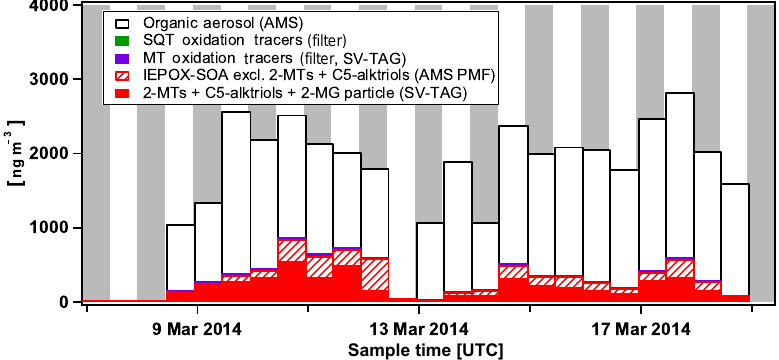
Figure 8. Estimated contributions to total organic aerosol from particle-phase tracers and statistical factors attributed to the oxidation of isoprene (red; IEPOX-SOA, 2-MTs + C 5 -alktriols + 2-MG), monoterpene (purple; MT filter tracers), and sesquiterpene (green; SQT filter tracers). 2-MTs: 2-methyl tetrols, 2-MG: 2-methylglyceric acid, C 5 -alktriols: C 5 -alkene triols. Local nighttime hours indicated in